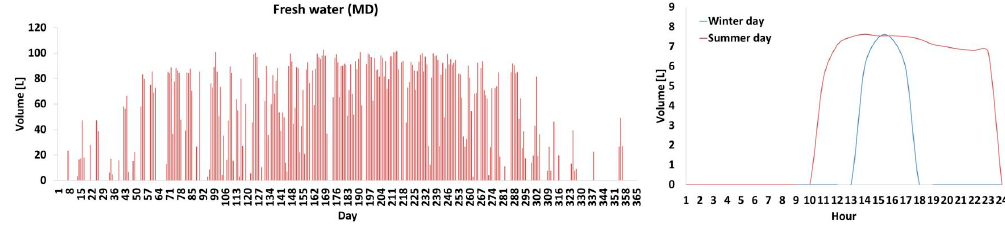
Figure 9. FW production by MD unit along the year.